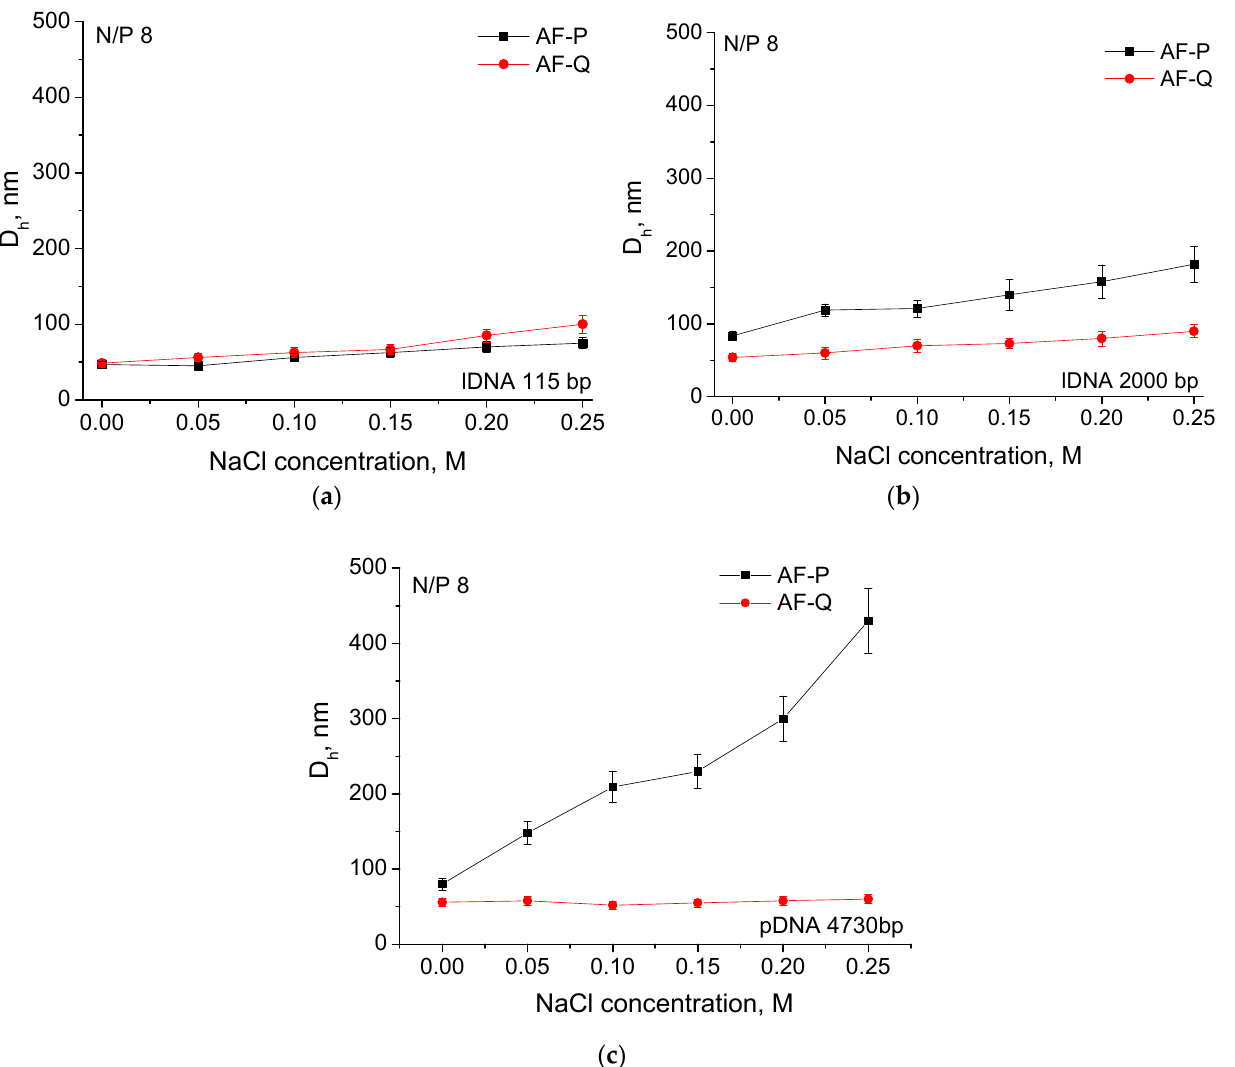
Figure 5. Variations of the hydrodynamic diameters, D h , with NaCl concentration of polyplexes based on PDMAEMA star-shaped polymers prepared at N/P ratio of 8 with ( a ) lDNA 115, ( b ) lDNA 2000 and ( c ) pDNA 4730. 2000 and ( c ) pDNA